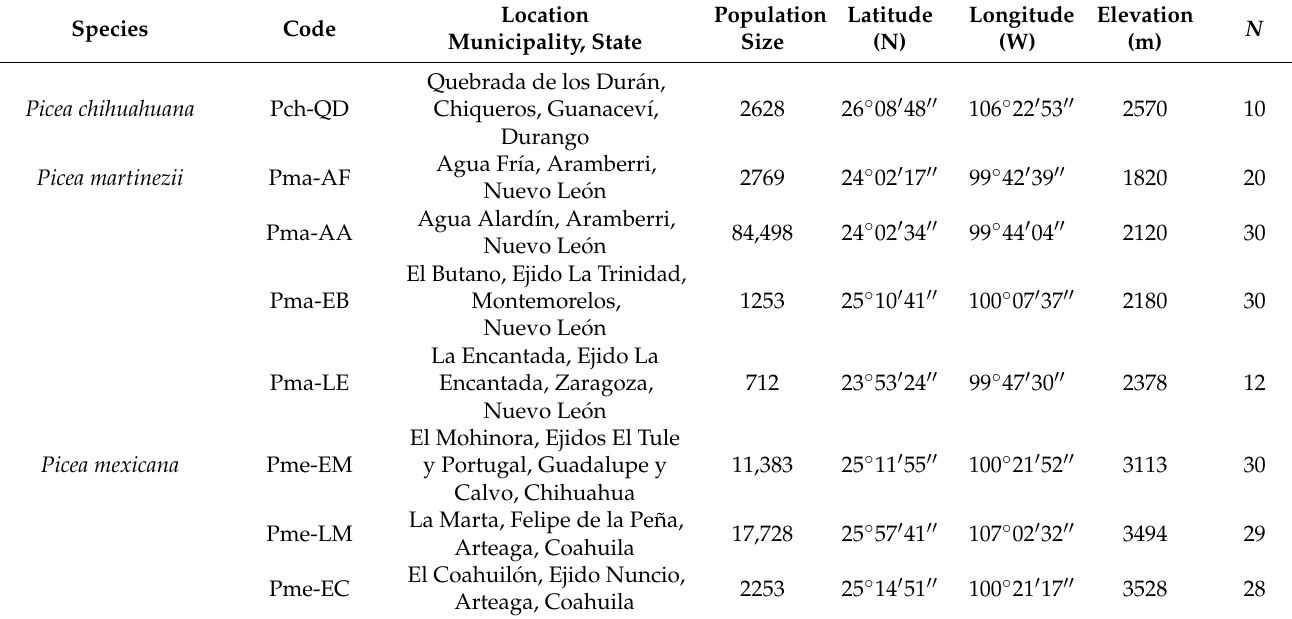
Table 1. Location and population size of the eight provenances of three species of Mexican spruces under study and number of trees sampled ( N ); data of Picea chihuahuana from [20] and of P. martinezii and P. mexicana from